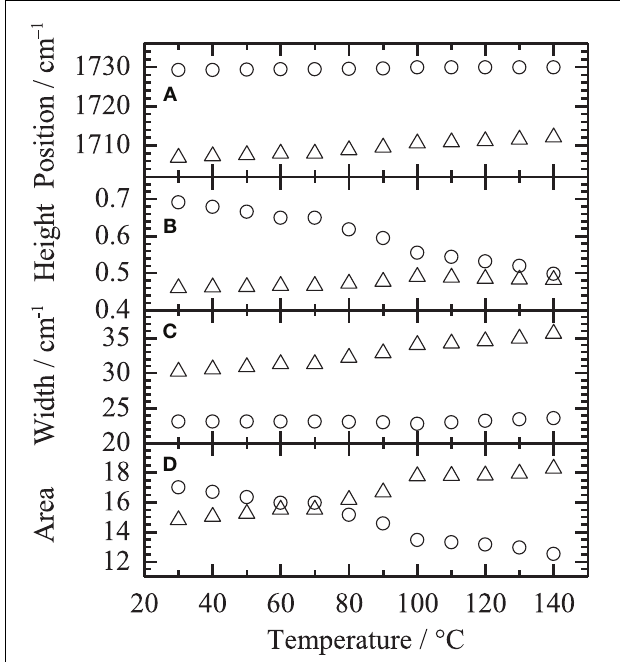
FIGURE 7 | Fitting parameters of (A) peak position, (B) peak height, (C) peak width and (D) area intensity in the C = O stretching region plotted as a function of temperature. Symbols of circle and triangle correspond to the bands around 1730 and 1703cm − 1 , respectively.